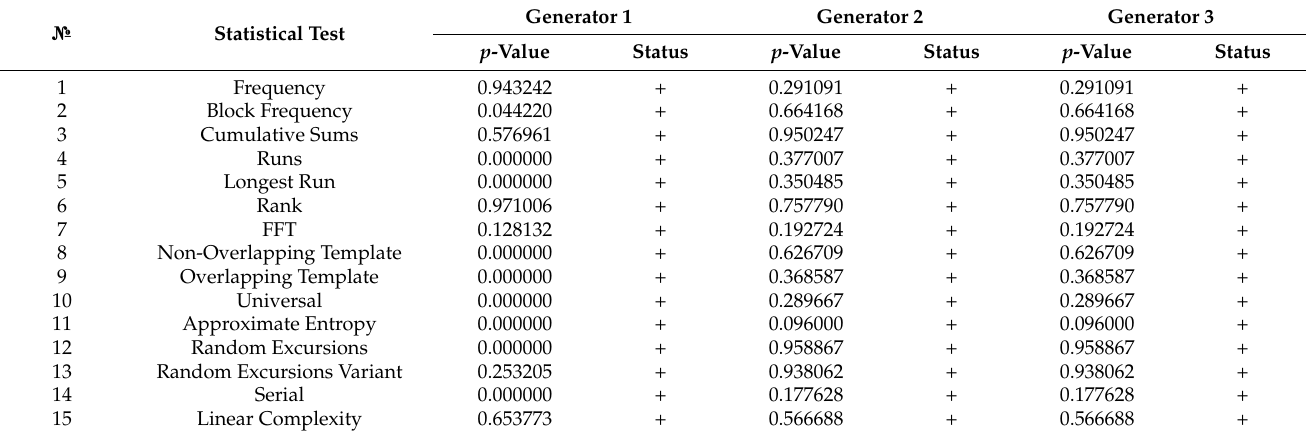
Table 5. p -Values of statistical tests for combined generator.